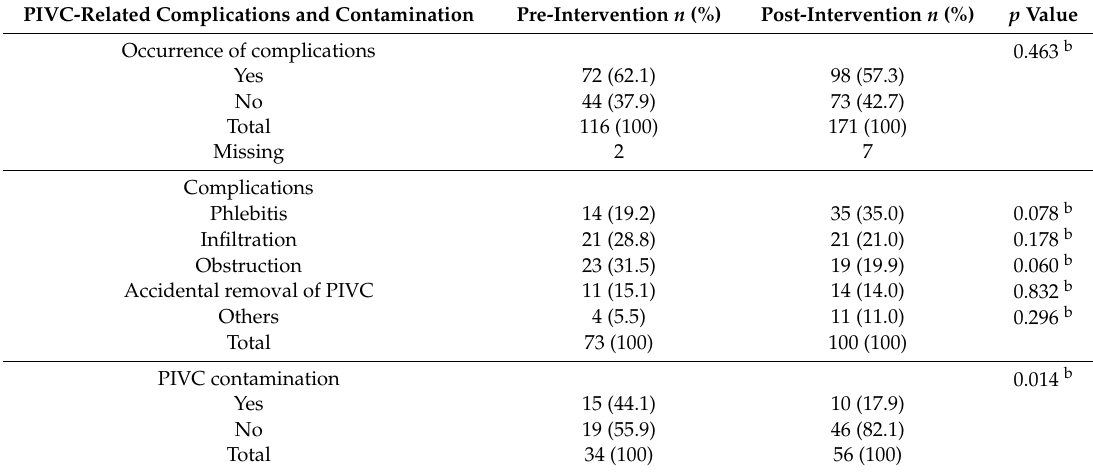
Table 3. Occurrence of complications associated with peripheral IV catheterization and the incidence of PIVC contamination in each phase along with the statistical significance between pre- and post-intervention